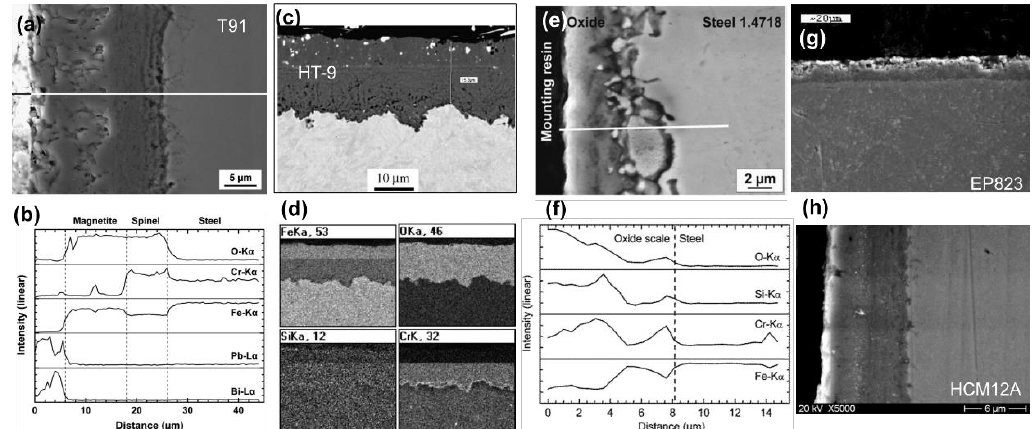
Figure 1. SEM corrosion morphology and EDS element distributions of ferritic/martensitic (F/M) steel after lead-bismuth (LBE) corrosion. ( a , b ) T91 [30], ( c , d ) HT-9 [31], ( e , f ) 1.4718 steel [32], ( g ) EP823 [33], ( h ) HCM12A [34]. Figure 1a,b reprinted